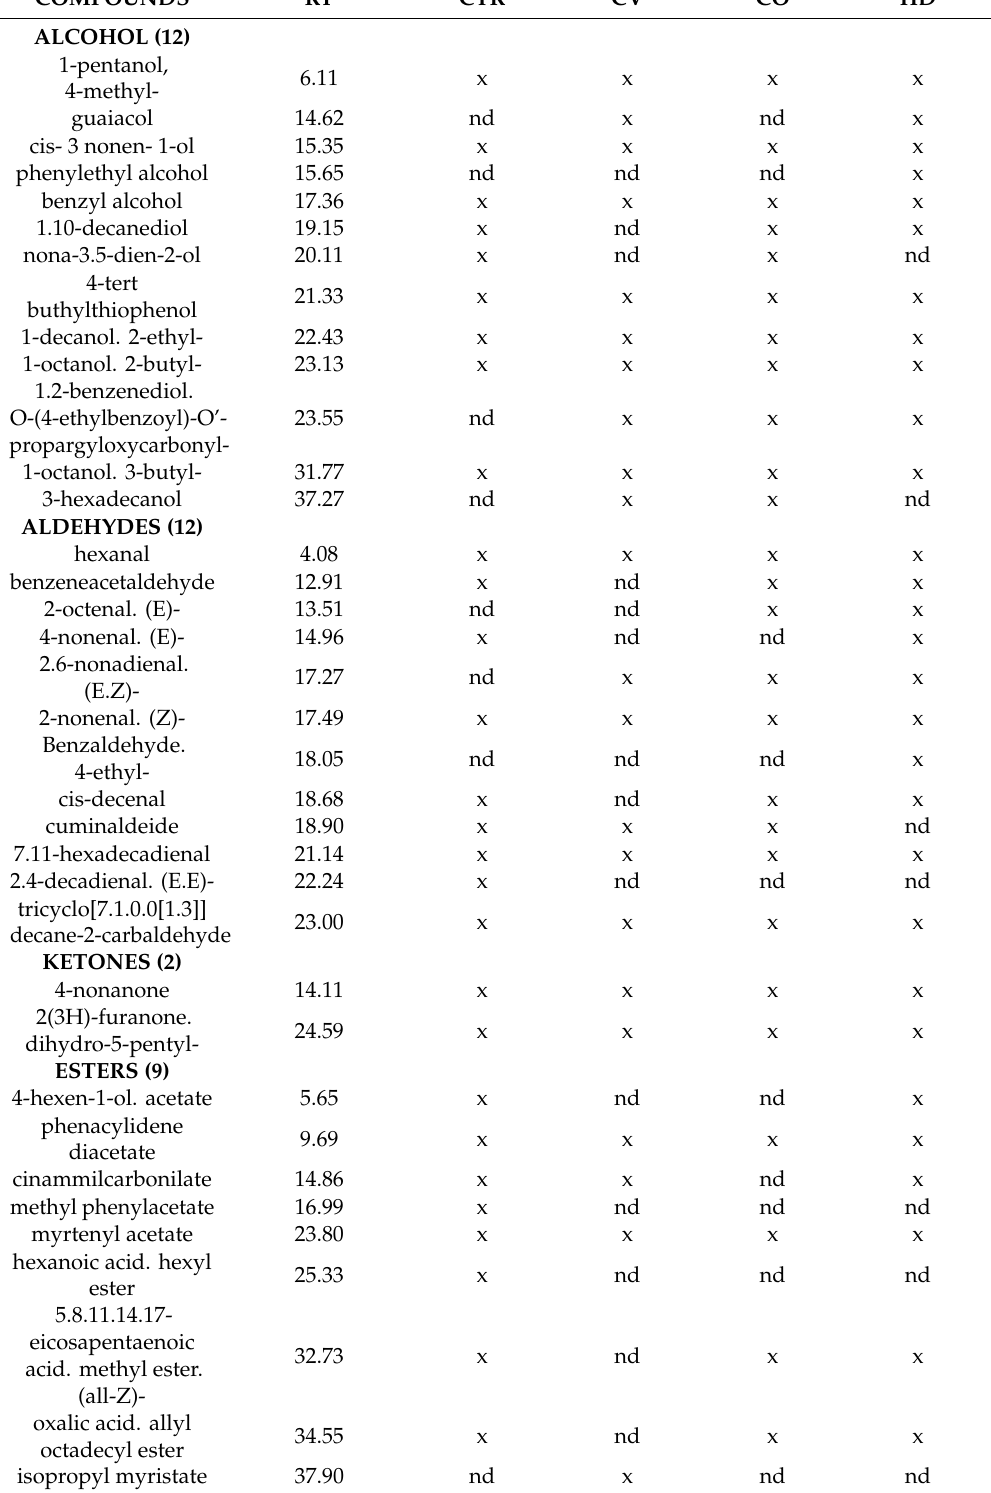
Table 4. - Summary of compounds identified in red Topepo fruits grown in unfertilized soil control (CTR) and soils fertilized with compost from olive wastes (CO), compost from vegetable wastes (CV), and horse dung